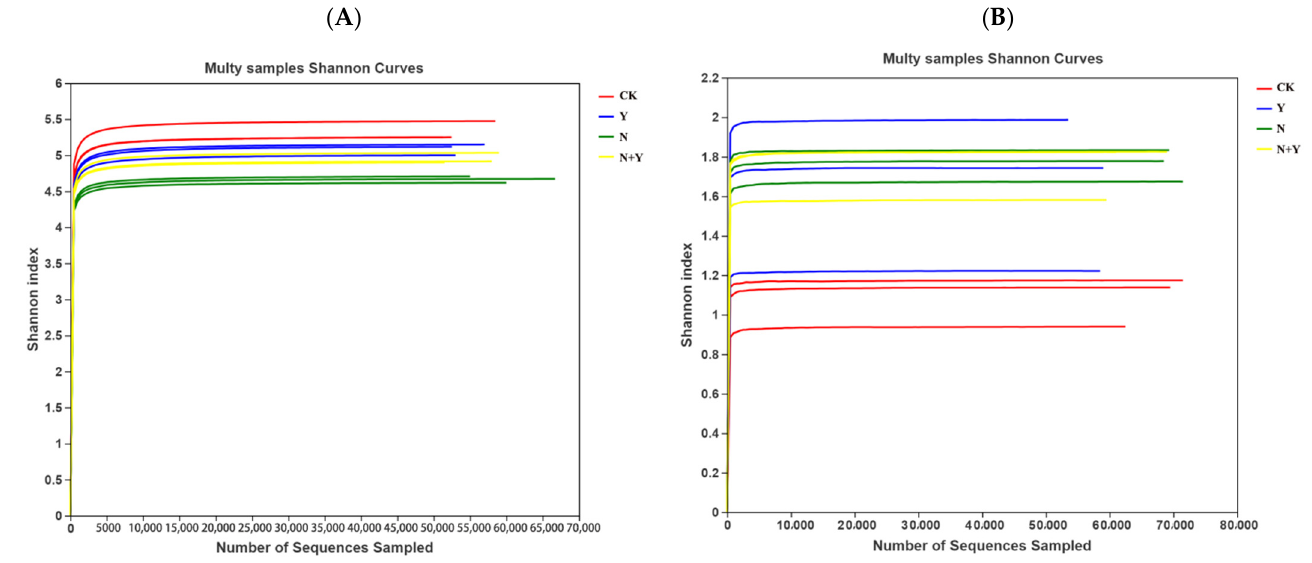
Figure 2. Shannon index curves at 97% similarity levels of rhizospheric growth media samples collected from different treatments. Different treatments: CK (control), seedlings were irrigated with normal nutrient solution; Y, control + B. subtilis K424; N, four-strength control; N + Y, four-strength control + B. subtilis . K424 ( A ) bacteria; ( B ) fungi.